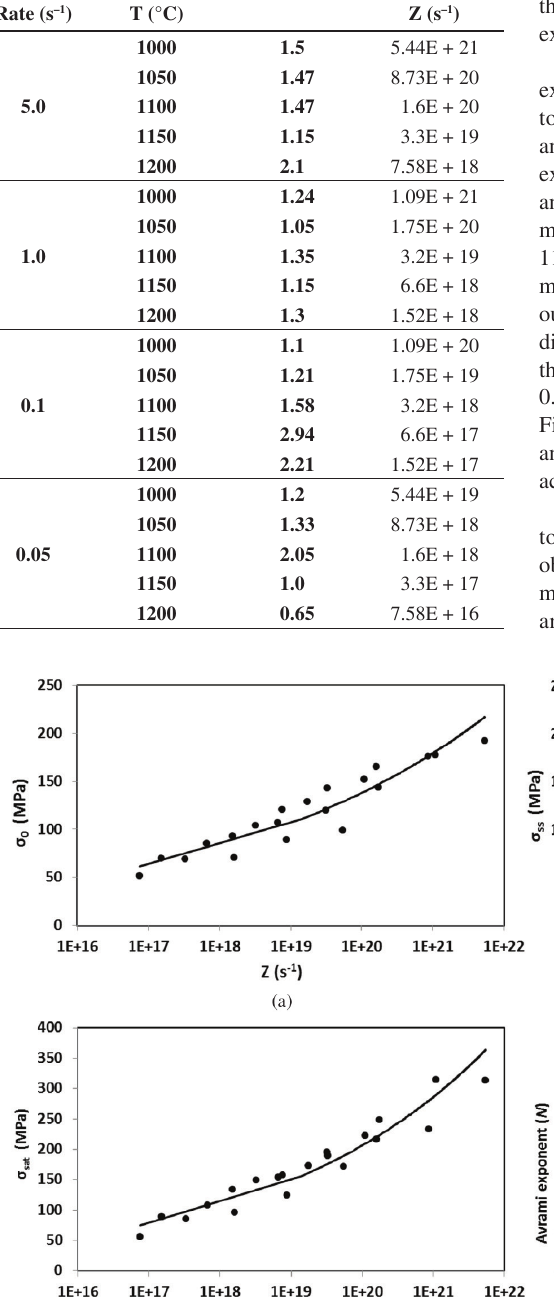
Table 2. Avrami exponent Values (n) for various thermomechanical treatment conditions imposed on the material. Rate (s –1 )